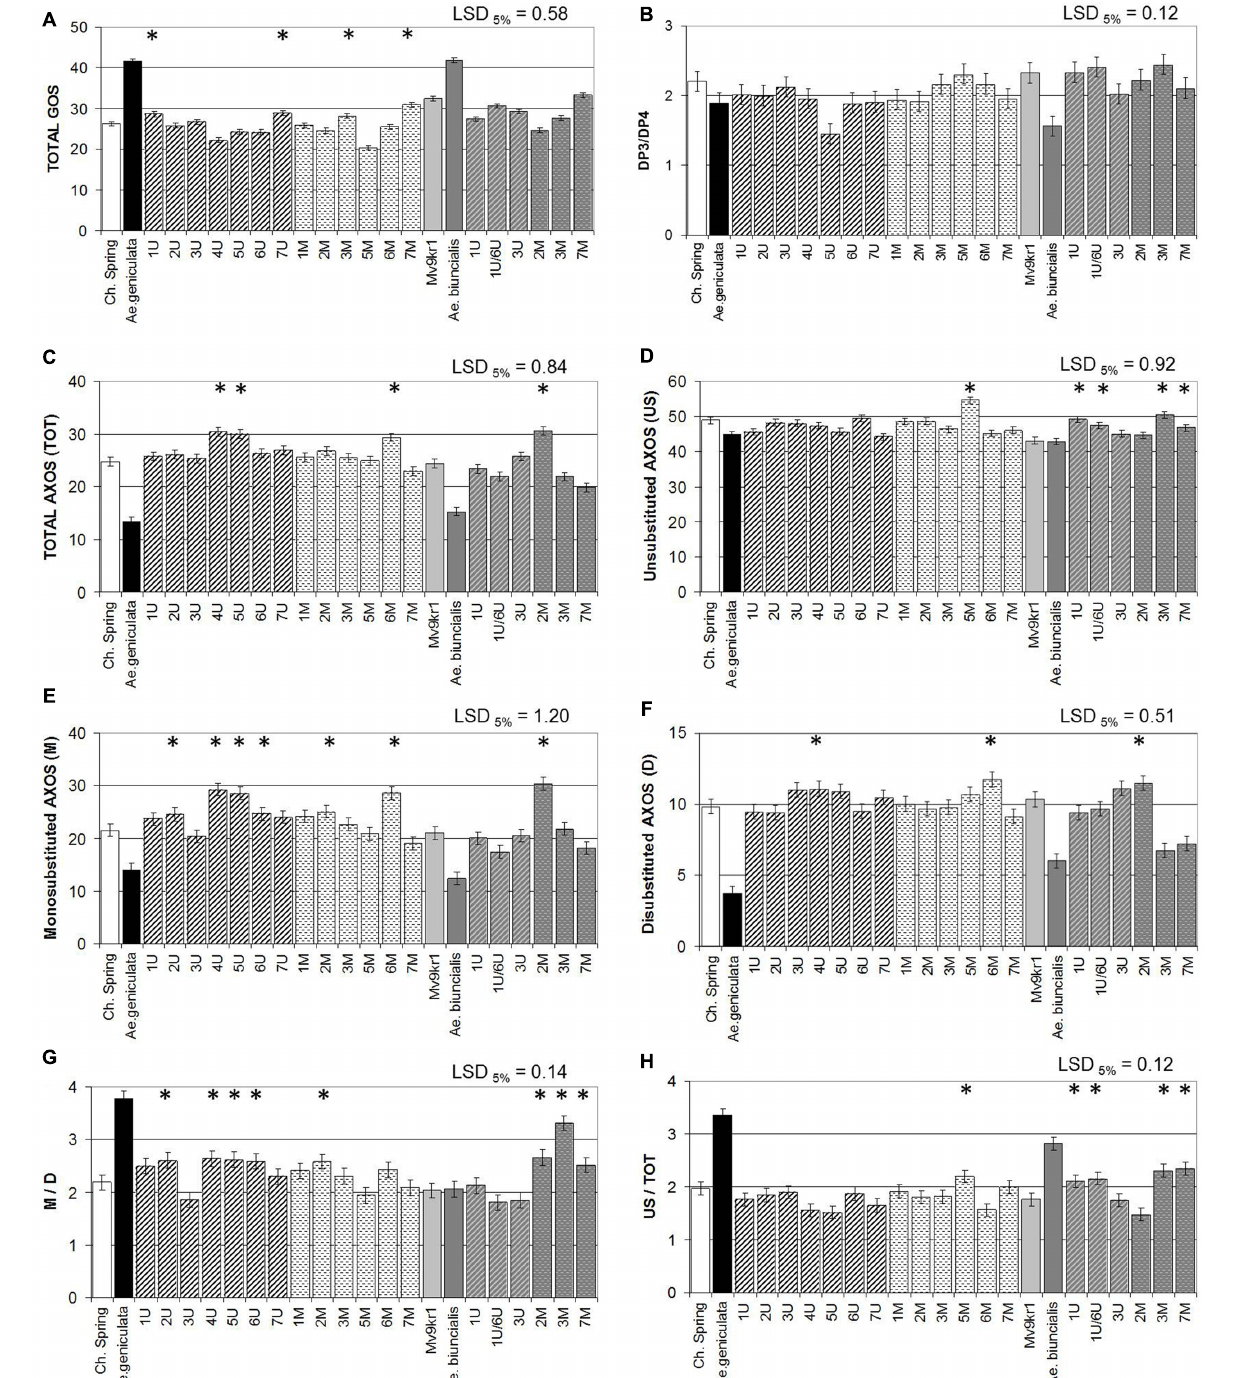
Frontiers in Plant Science |